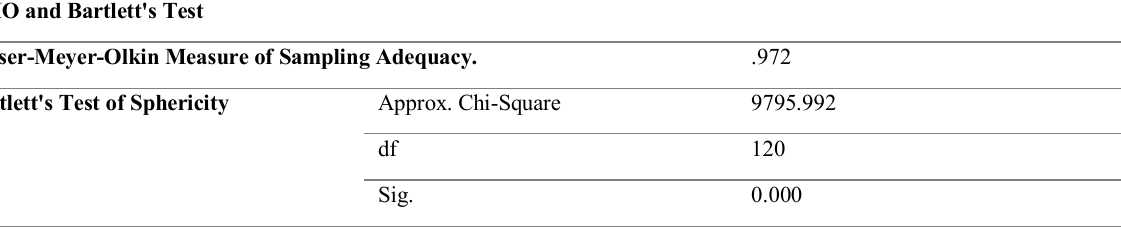
Table 2: KMO and Bartlett's test for continuous quality improvement